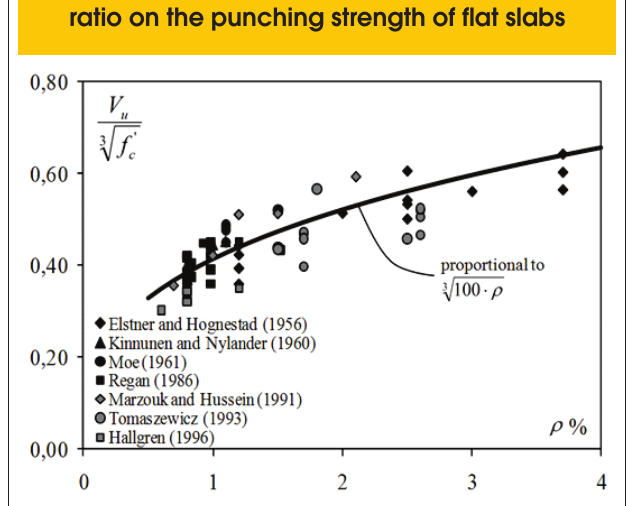
Figure � � �nfluence of the fle�ural reinforcement ratio on the punching strength of flat